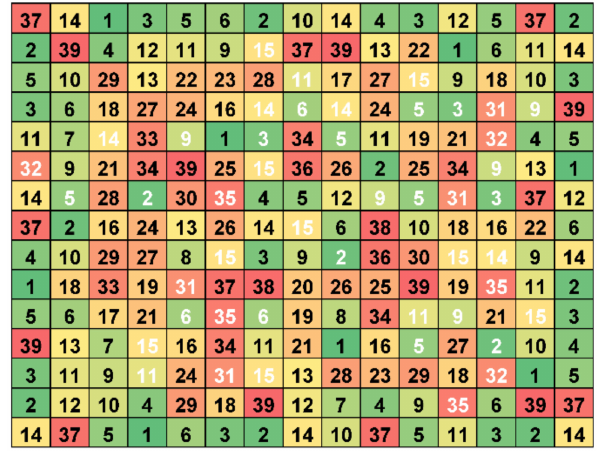
Figure 1. Example of the Optimum Neighborhood Algorithm design for refilling empty positions in an existing orchard. Numbers designate individual clones’ IDs. Numbers in white color represent refilled positions utilizing the ONA algorithm.